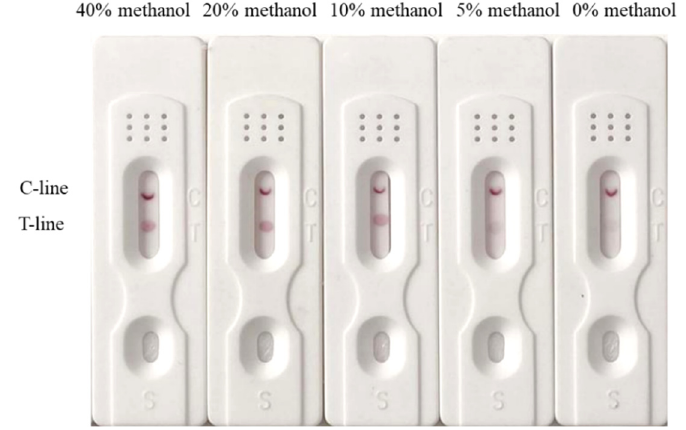
Figure 5. Evaluating the effect of methanol on the test line.